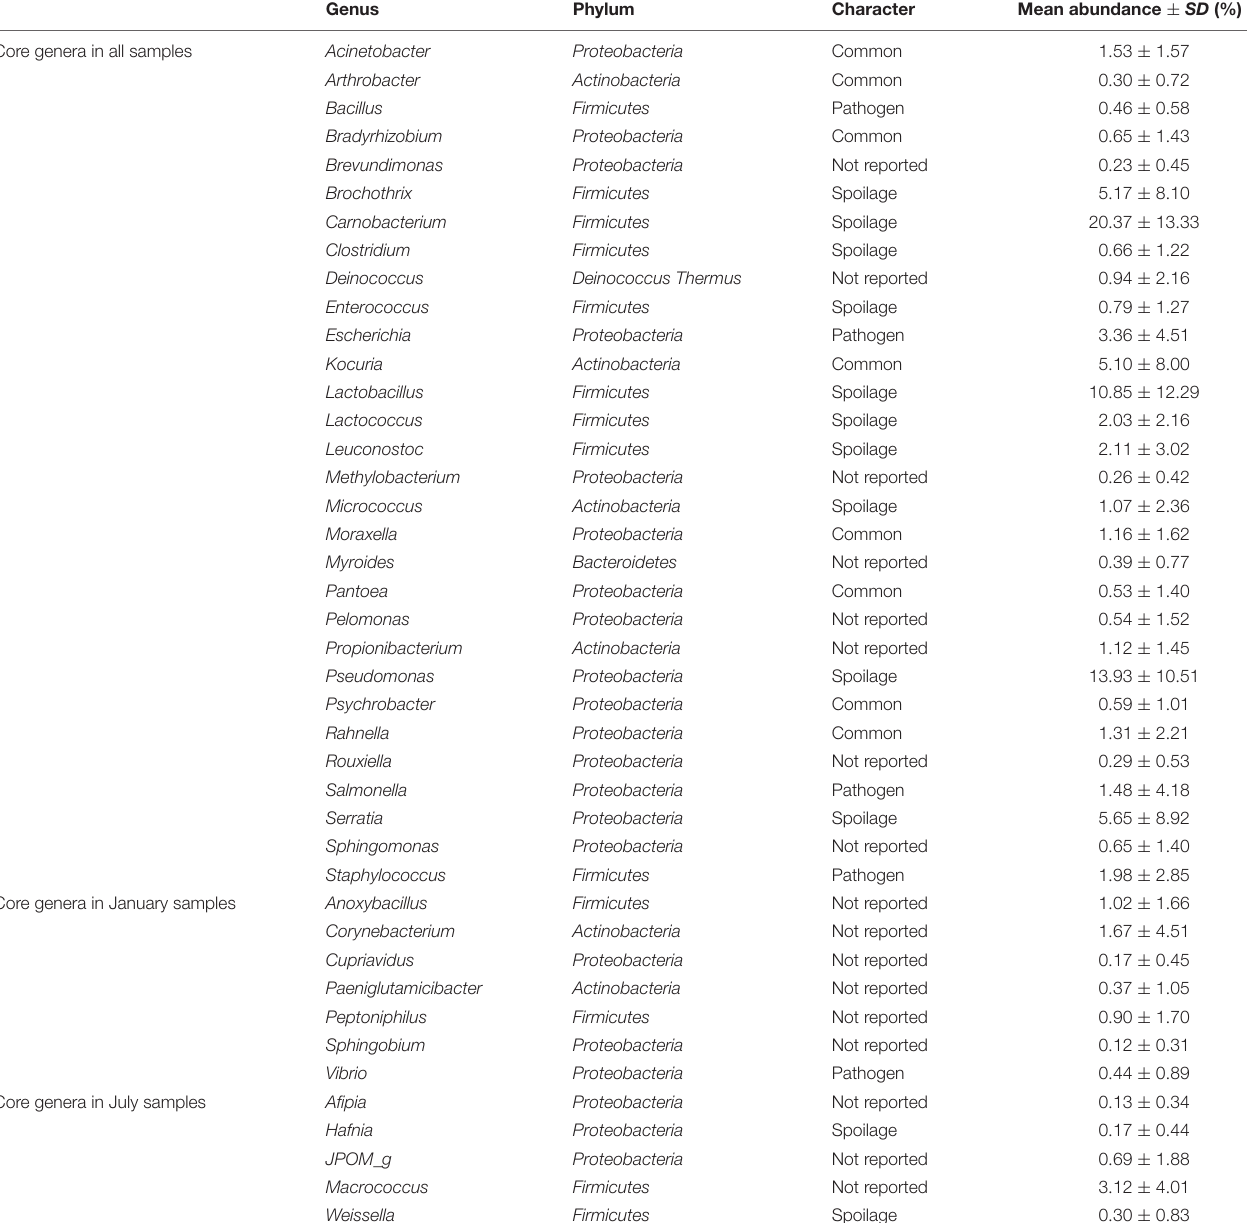
TABLE 1 | Core genera in the microbiota of beef meat. Genera were classified into four character groups according to the previous studies (Nychas et al., 2008; Doulgeraki et al., 2012; Iulietto et al.,